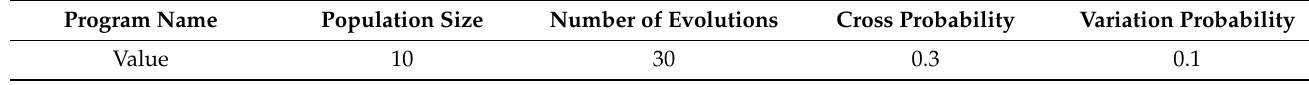
Table 5. Parameters of genetic